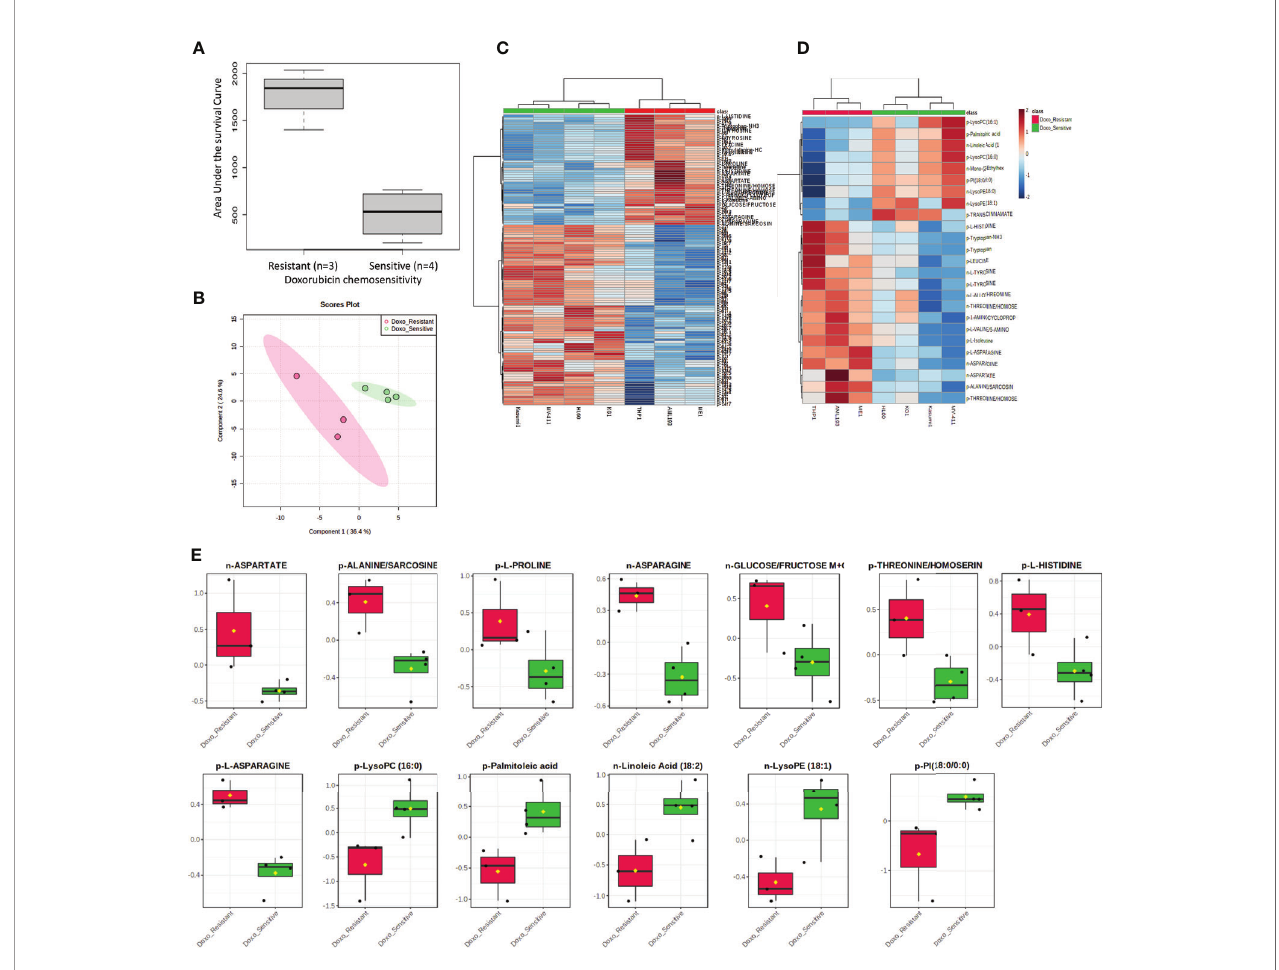
FIGURE 1 | Metabolome analysis by doxorubicin in vitro chemosensitivity in AML cell lines. (A) Box plot showing differential AUC values between doxorubicin sensitive and resistant cell lines. (B) Multivariate metabolomics analysis of AML cell line doxorubicin chemosensitivity groups. PLSDA plot of cell samples shows global separation by doxorubicin chemosensitivity (Sensitive n=4 and Resistant n=3). (C) Clustering metabolomics analysis of AML cell line doxorubicin chemosensitivity groups. Heatmap shows relative abundance patterns of 122 cell metabolites (annotated and un-annotated) with signi fi cantly different abundance between groups. Clustering within the heatmap shows a clear distinction of several metabolites between the sensitive and resistant groups. (D) Abundance patterns of top 25 annotated metabolites are shown in this Heatmap. (E) Box plots of selected metabolites showing abundance by drug sensitivity groups. p, positive and n, negative ionization set.